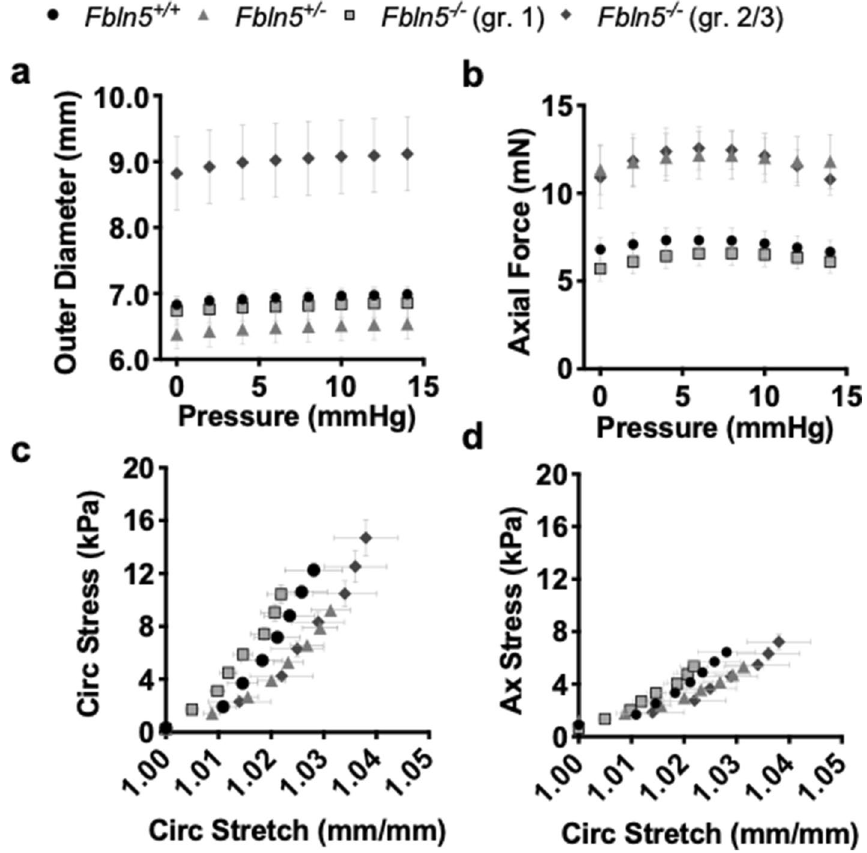
Figure 4. Curves for vaginal passive biomechanical behavior. Pressure versus outer diameter curves ( a ) for the Fbln5 +/+ (circle; n = 13), Fbln5 +/− (triangle; n = 13), Fbln5 -/- with grade 1 POP (square; n = 9), and Fbln5 -/- with grade 2/3 POP (diamond; n = 9) vaginas. The Fbln5 -/- with grade 2/3 POP vaginal diameter increased compared to the other groups denoted by the upward shift in the pressure versus diameter curve. Pressure versus axial force curve ( b ) for the Fbln5 +/− and Fbln5 -/- with grade 2/3 POP shifted upwards compared to Fbln5 +/+ and Fbln5 -/- with grade 1 POP. Circumferential ( c ; circ) and axial ( d ; ax) stress versus circumferential stretch curves. Vaginal distensiblility increased for Fbln5 +/− and Fbln5 -/- with grade 2/3 POP with respect to Fbln5 +/+ and Fbln5 -/- with grade 1 POP as denoted by the rightward shift in the stress versus stretch curves. Data is reported as mean ± standard error of mean. Less points are plotted than used in the analysis and the error bars are a light grey in order to visualize the